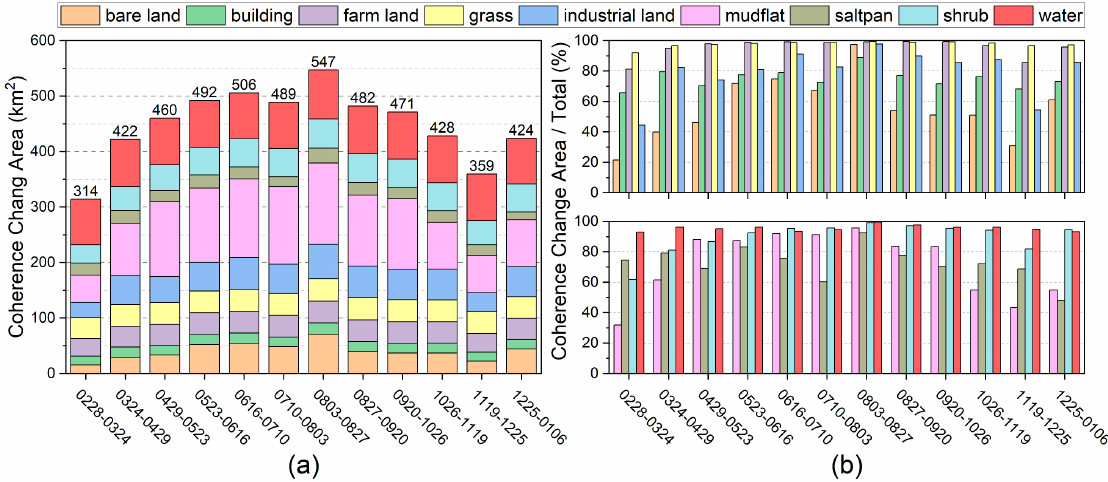
Figure 13. ( a ) Area of coherence change for nine land cover types in different months, 2019. The value above the bar is the total area of coherence change in study area in the corresponding period. ( b ) The proportion of the coherence change area for nine land cover types to the total area of each land cover type in 2019.